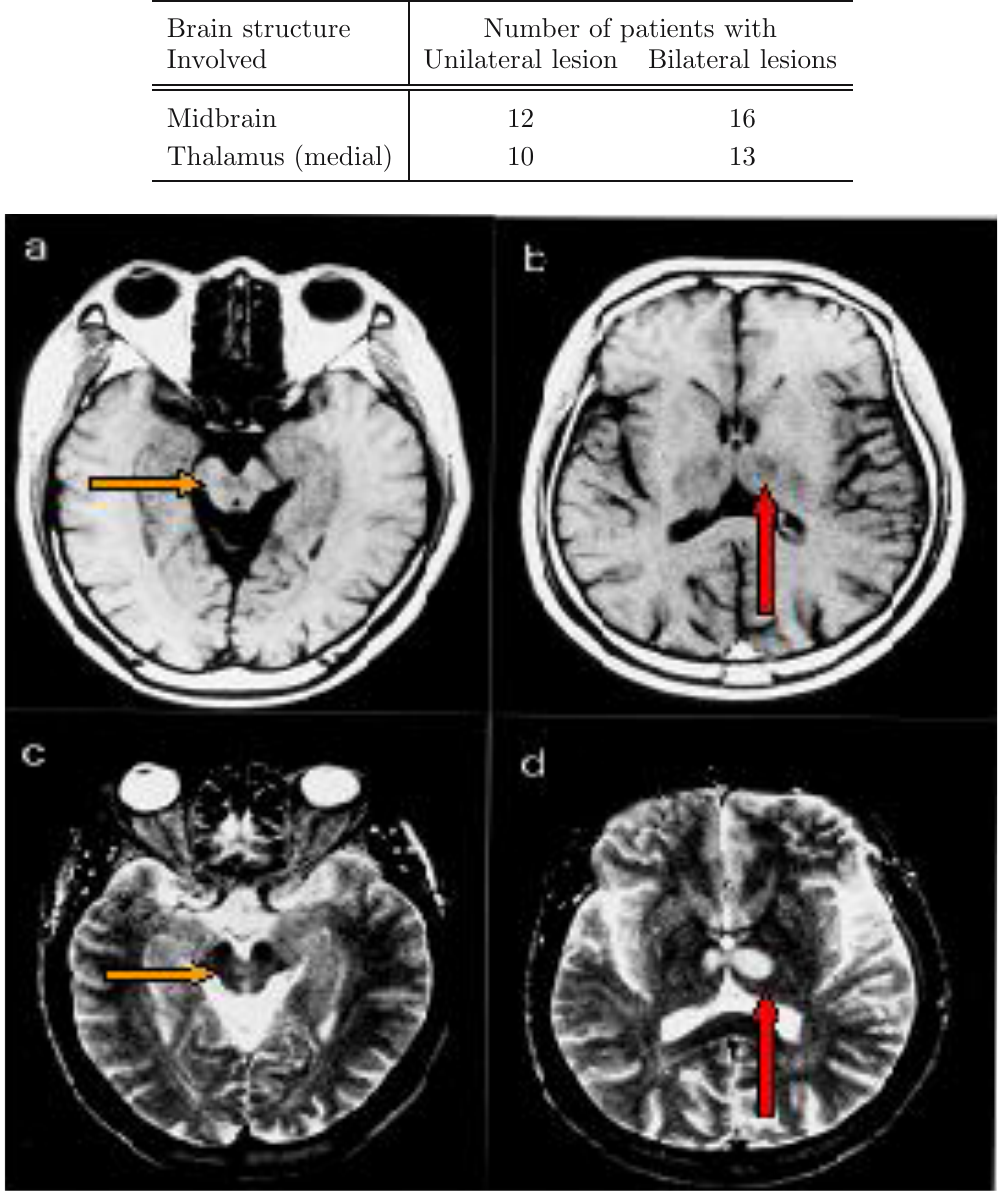
Fig. 2 Magnetic resonance images show acute bilateral infarctions of the paramedian mid- brain and medial thalamus in a patient with paramedian mesencephalic artery syndrome (A, B: T1-weighted images; C, D: T2-weighted